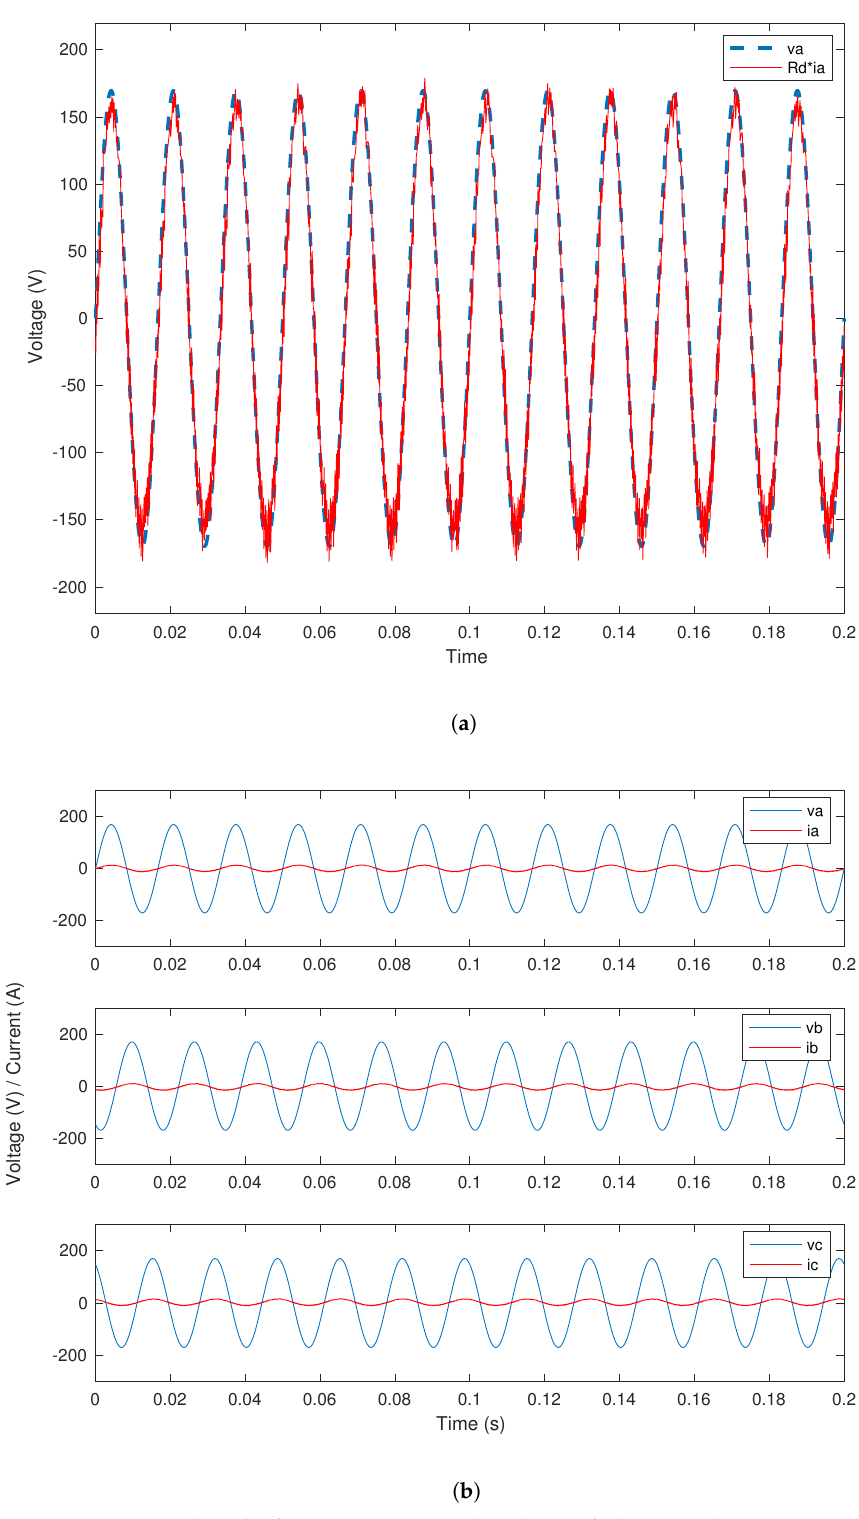
Figure 9. Experimental results for R d = 10 Ω . ( a ) The voltage of Phase-a and its current multiplied by R d . ( b ) The input voltage and current of each